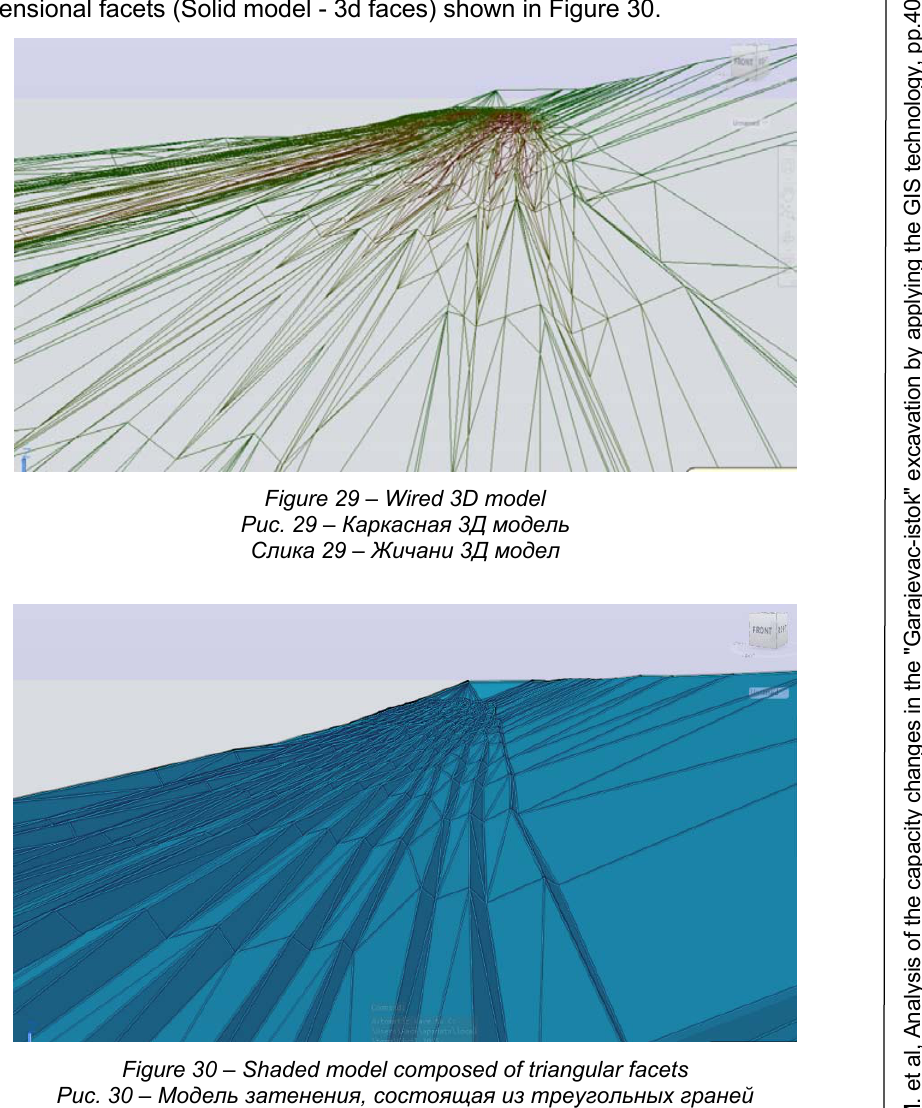
Figure 30 – Shaded model composed of triangular facets Рис . 30 – Модель затенения , состоящая из треугольных граней Слика 30 – Сенчени модел који се састоји од троугаоних